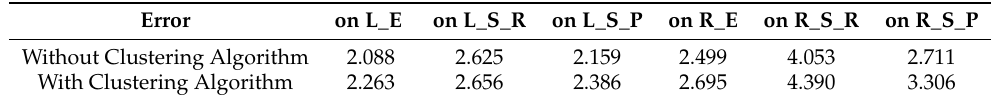
Table 5. Group algorithms comparison